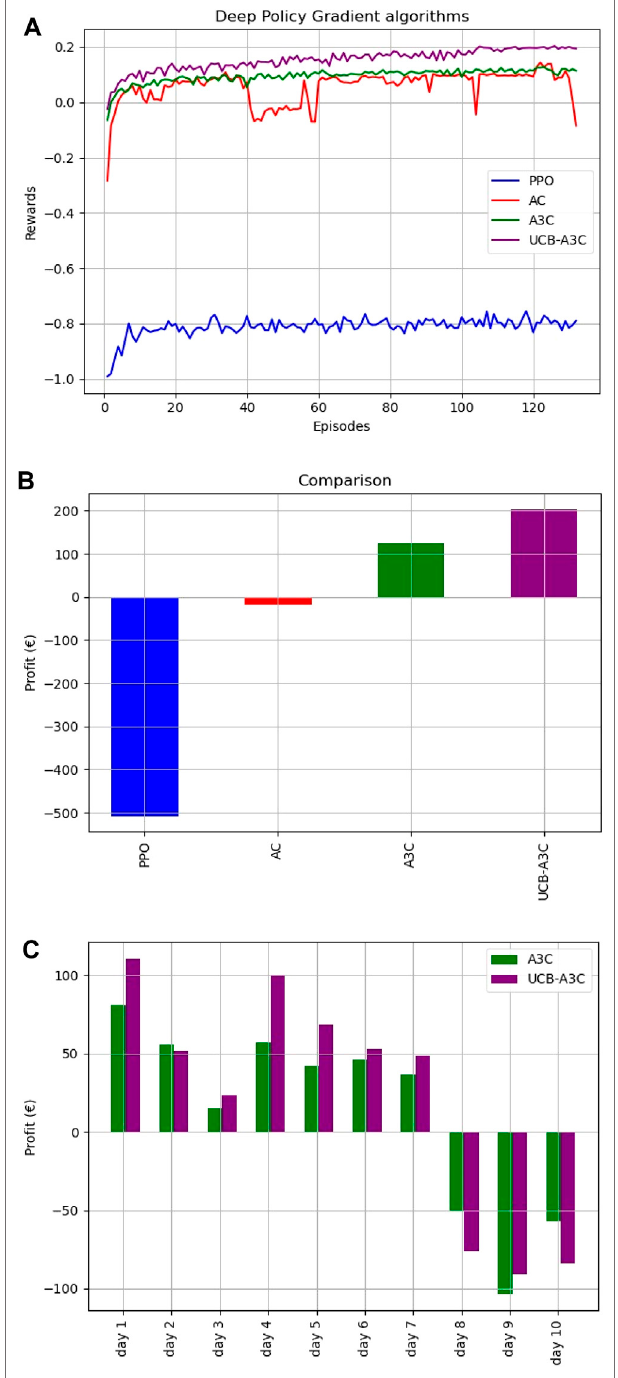
FIGURE 2 | Analysis of the UCB-A3C algorithm, (A) is the reward of the UCB-A3Calgorithm, (B) isthetotaleconomicpro fi ts, (C) isthedailyeconomic pro fi ts.